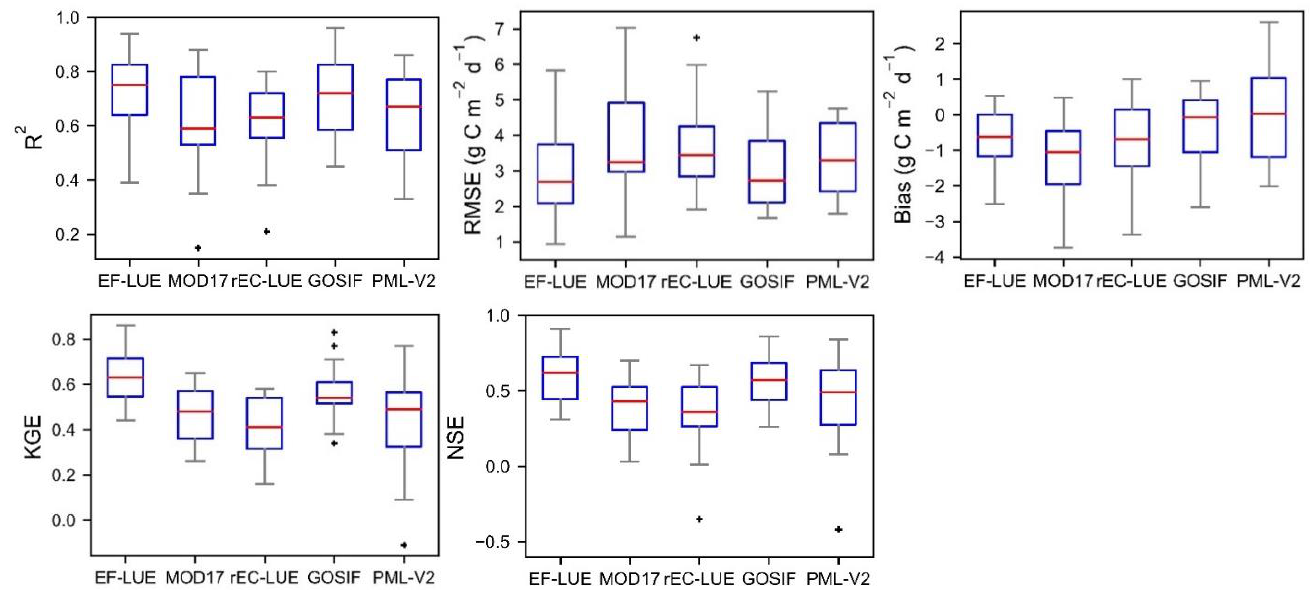
Figure 6. Boxplot for comparisons of 8-d mean GPP between the EF-LUE GPP, MOD17 GPP, revised EC-LUE (rEC-LUE in the figures) GPP, GOSIF GPP, and PML-V2 GPP with the GPP measurements at cropland flux tower sites in 2002 – 2018.